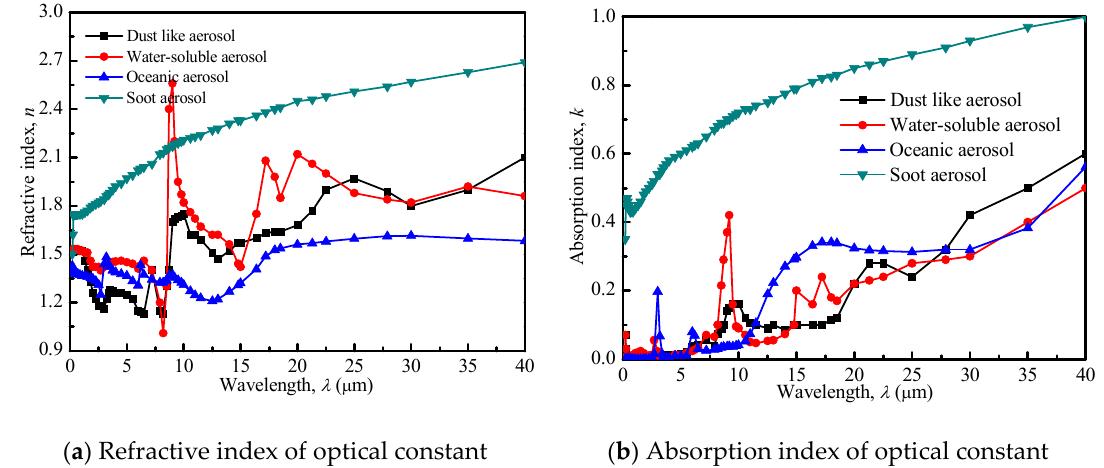
Figure 1. Spectral optical constants of four different kind of aerosols [25,26].